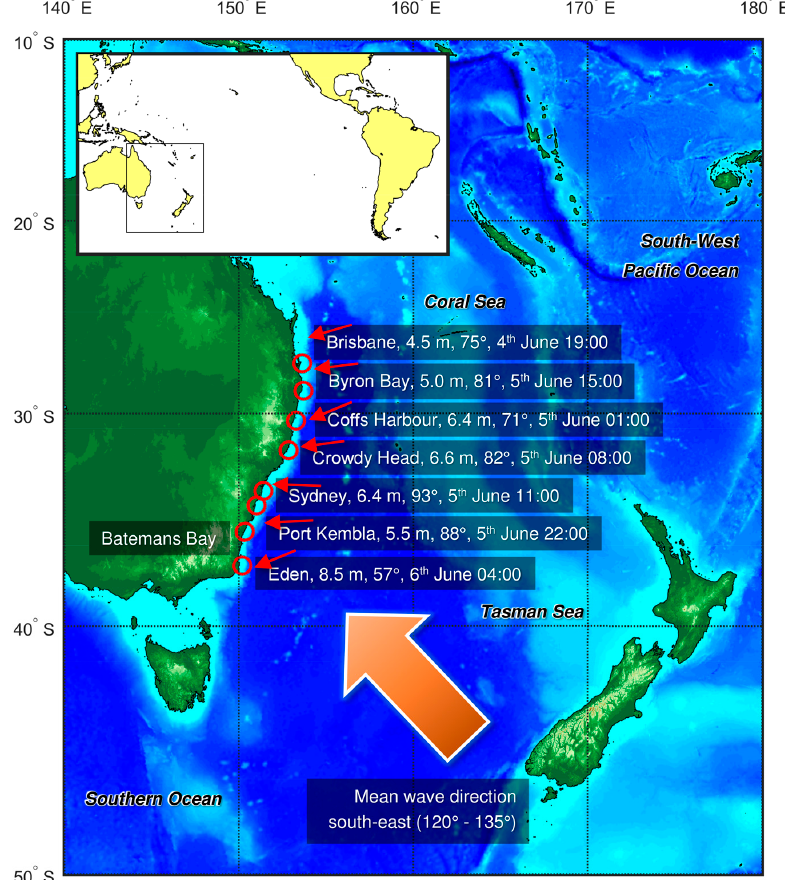
Figure 1. Map of the Tasman and Coral Seas region with locations of waverider buoys in Southeast Australia (red circles). The Tasman Sea borders the east coast of Australia, and extends west to New Zealand. It extends north to where it meets the Coral Sea at approximately 30° S [8]. The peak storm hourly significant wave height, mean wave direction, and time of peak storm wave conditions during the June 2016 event, are given for each buoy location. The Batemans Bay buoy data transmission failed during the event [7]. Red arrows illustrate peak storm wave direction. Mean wave direction (range of averages for all buoys over portions of records having directional observations) is also shown. Inset shows the study region in relation to the Pacific Basin.